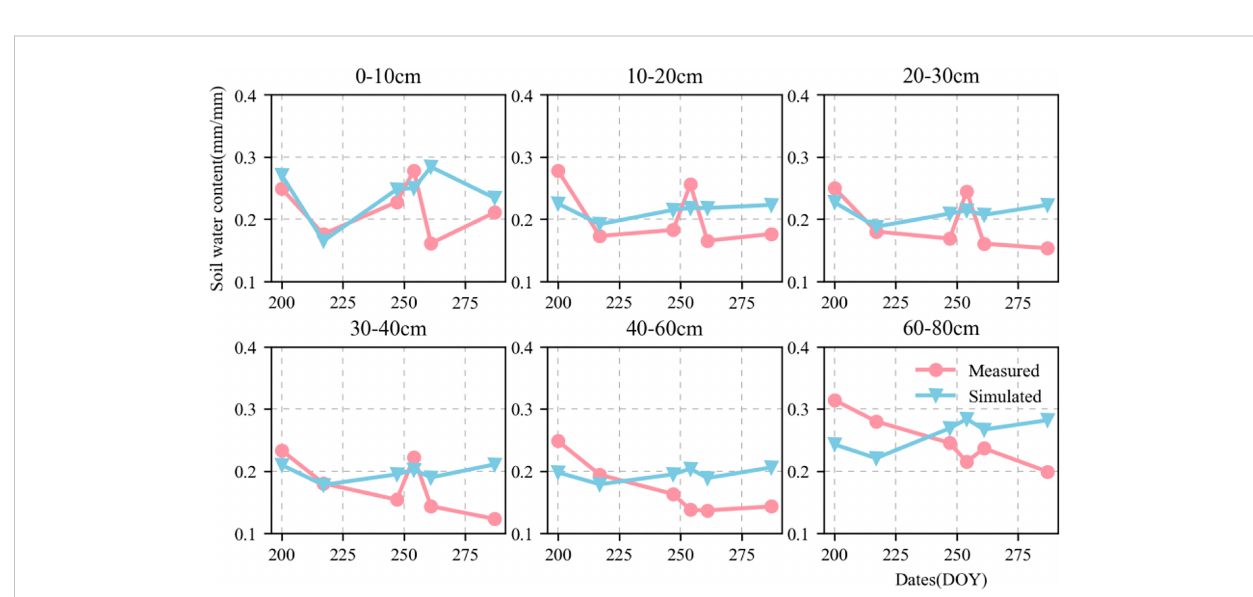
FIGURE 6 Dynamics of simulated (blue triangle) and measured (red circle) soil moisture content value in 0 – 80-cm soil pro fi le at Xinxiang site from 2018 to 2019.